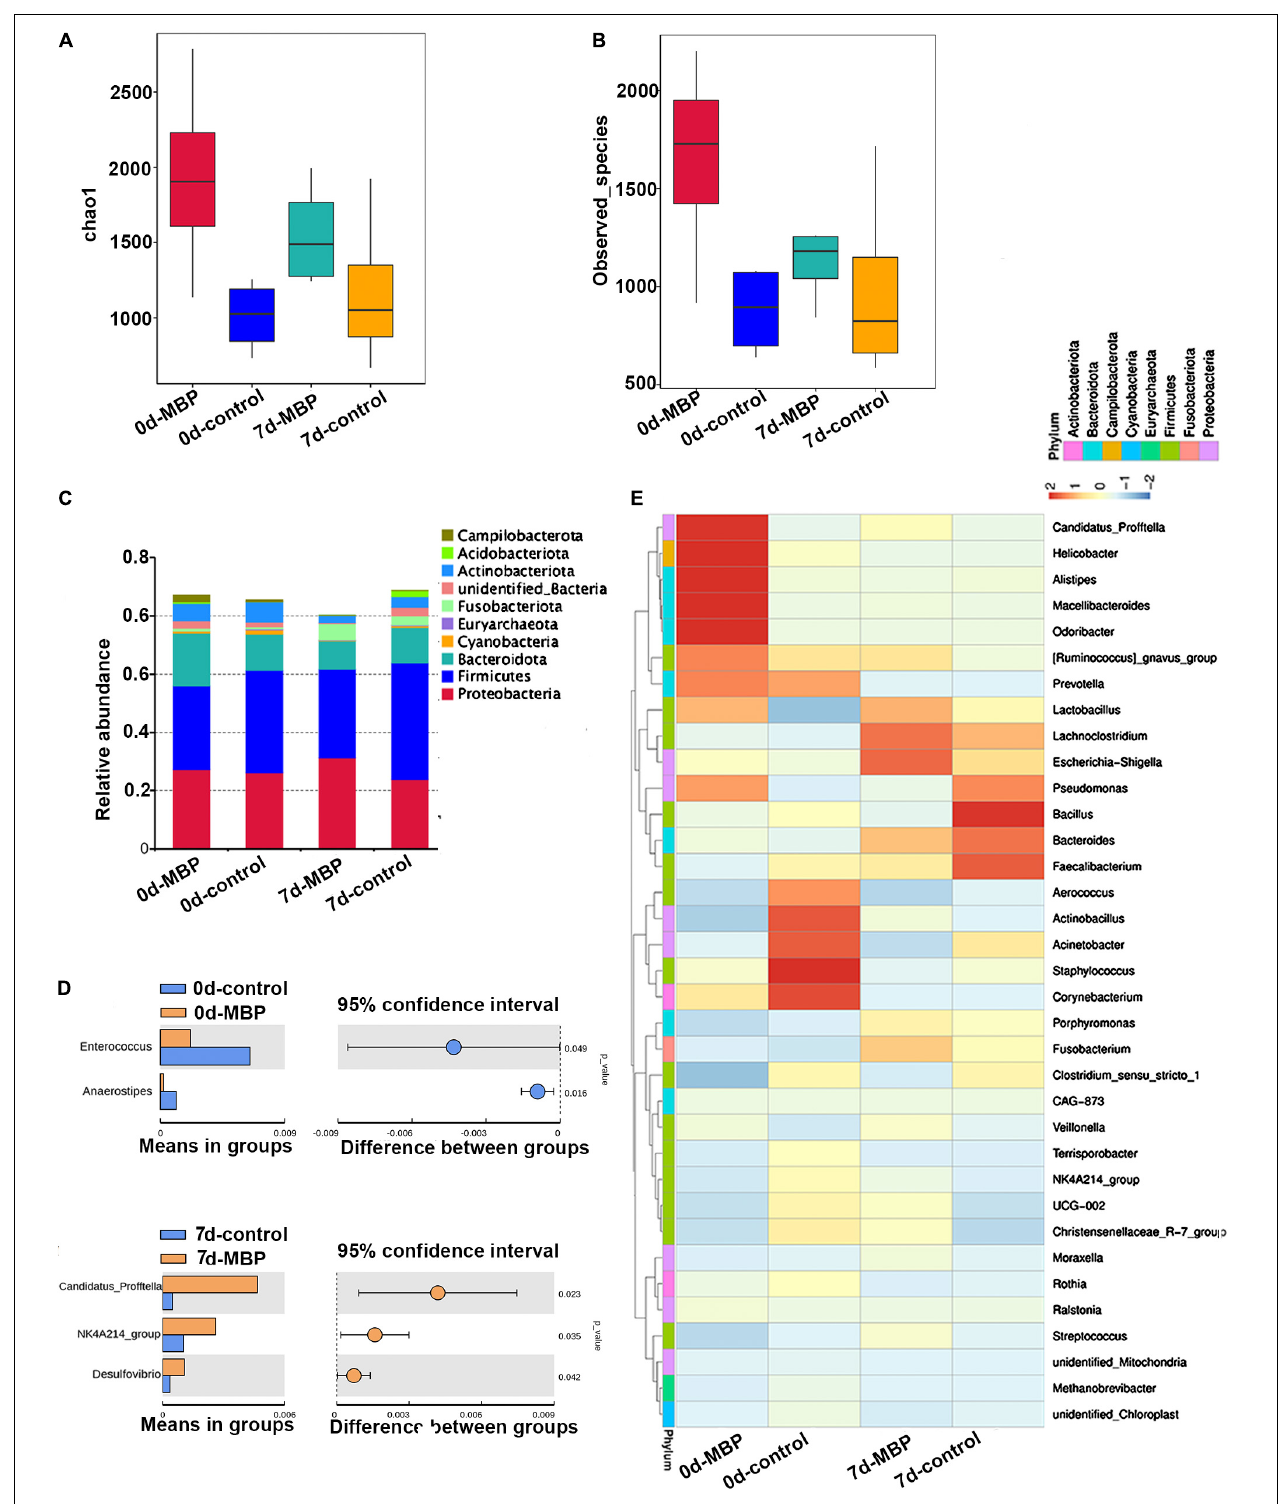
FIGURE 6 | Predominant bacteria in milk samples from sows fed with the MBP diet. Microbial α -diversity assessed by (A) Chao1 richness estimator and (B) observed species were calculated. (C) Phylum level. (D) Significant differences in bacteria at the genus level in milk samples between the two groups. (E) Relative abundance of bacterial taxa at the genus level (top of